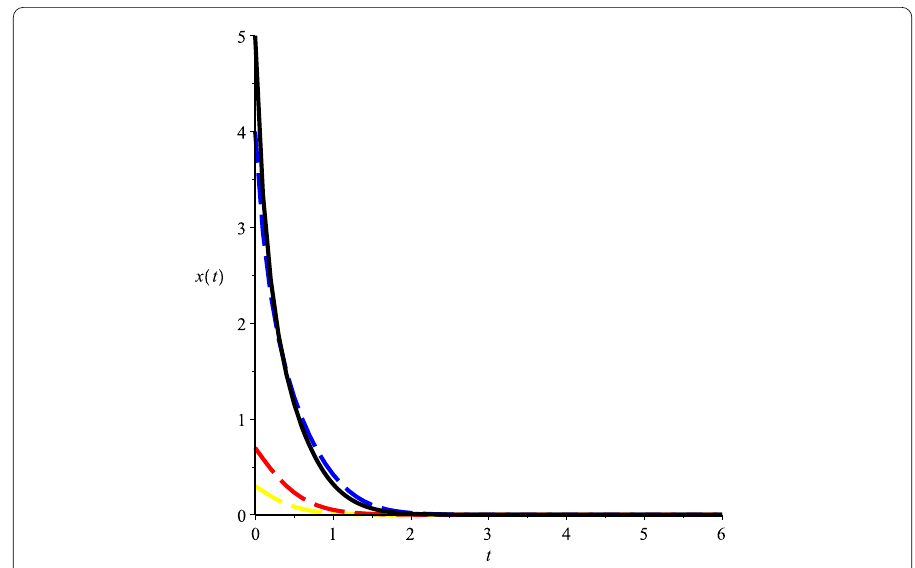
Figure 3 Numeric simulations of the second component of system (5.1), with the initial conditions ( x (0), y (0)) = (5,0.1),(4,1),(0.3,3) and (0.7,2),